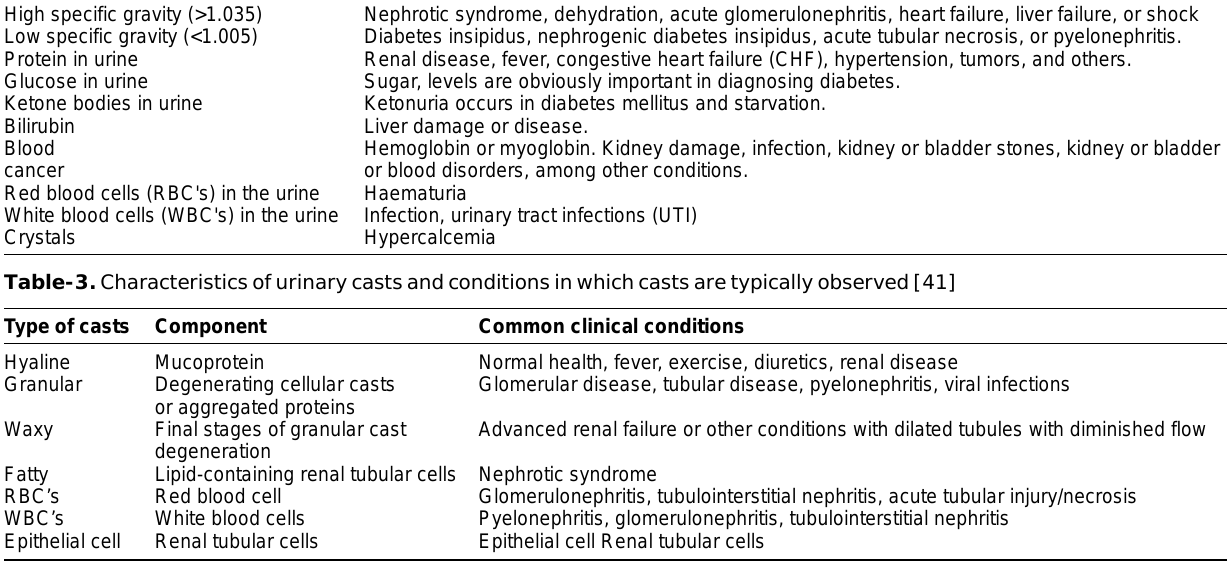
Table-2. Clinical conditions that can be identified using urinalysis [40] Parameters Clinical conditions